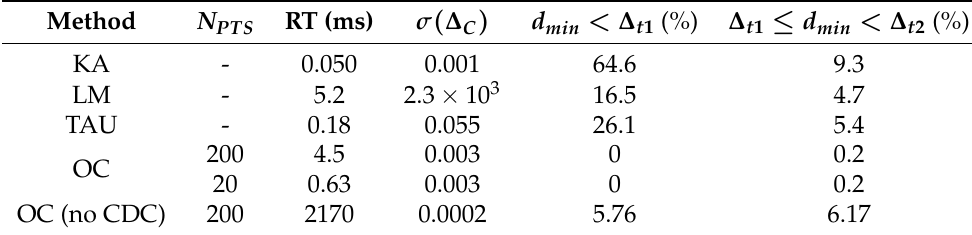
Table 4. Fitting results for case study